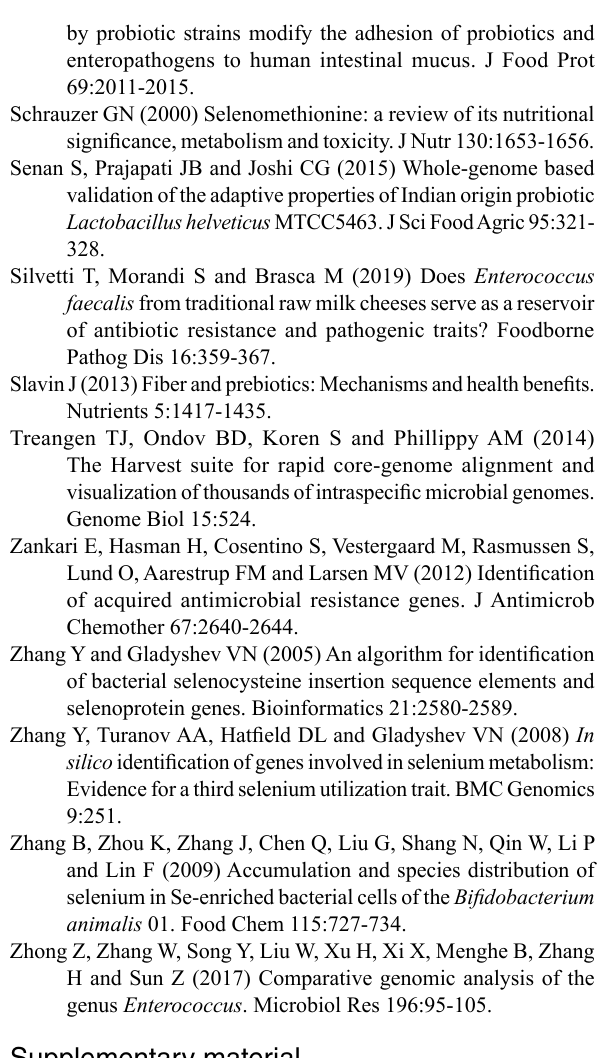
Figure S1 – E. durans LAB18S genes grouped into subsystems by RAST. Figure S2 – Multiple sequence alignment of colicin V gene from E. durans